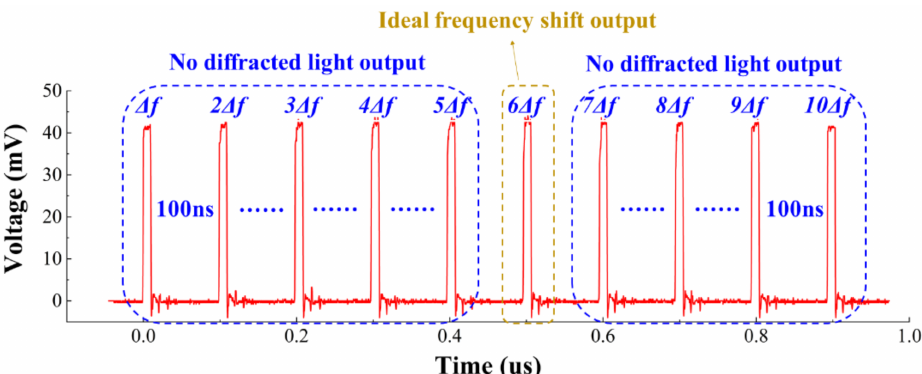
Figure 4. Schematic diagram of pulse